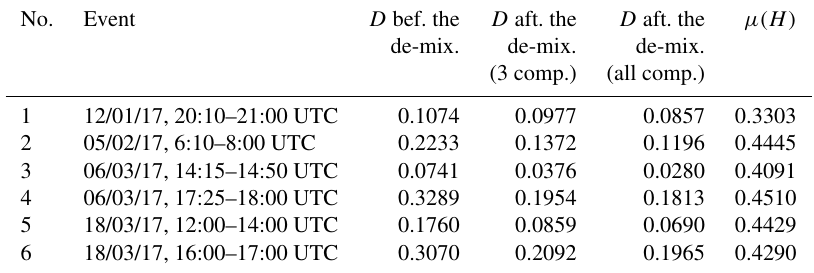
Table 2. Quantitative scores ( D ) of the Plaine Morte–MASC comparison before and after the bin-based de-mixing. Events 3 and 5 are illustrated respectively in Figs. 13 and